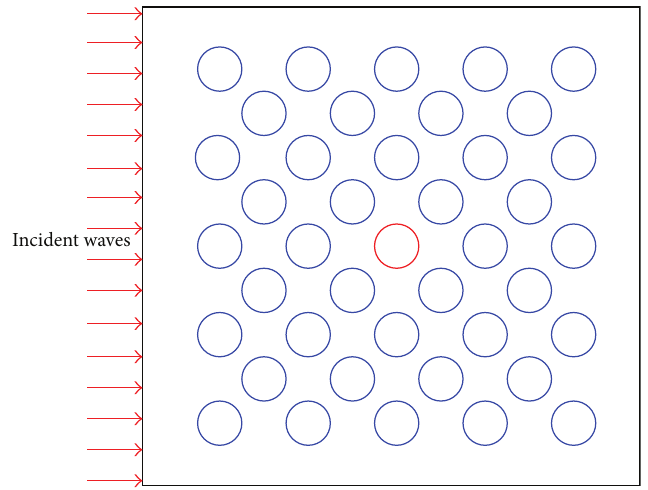
Figure 1: The diffraction of elastic waves by a cluster of infinity nanosized cylindrical